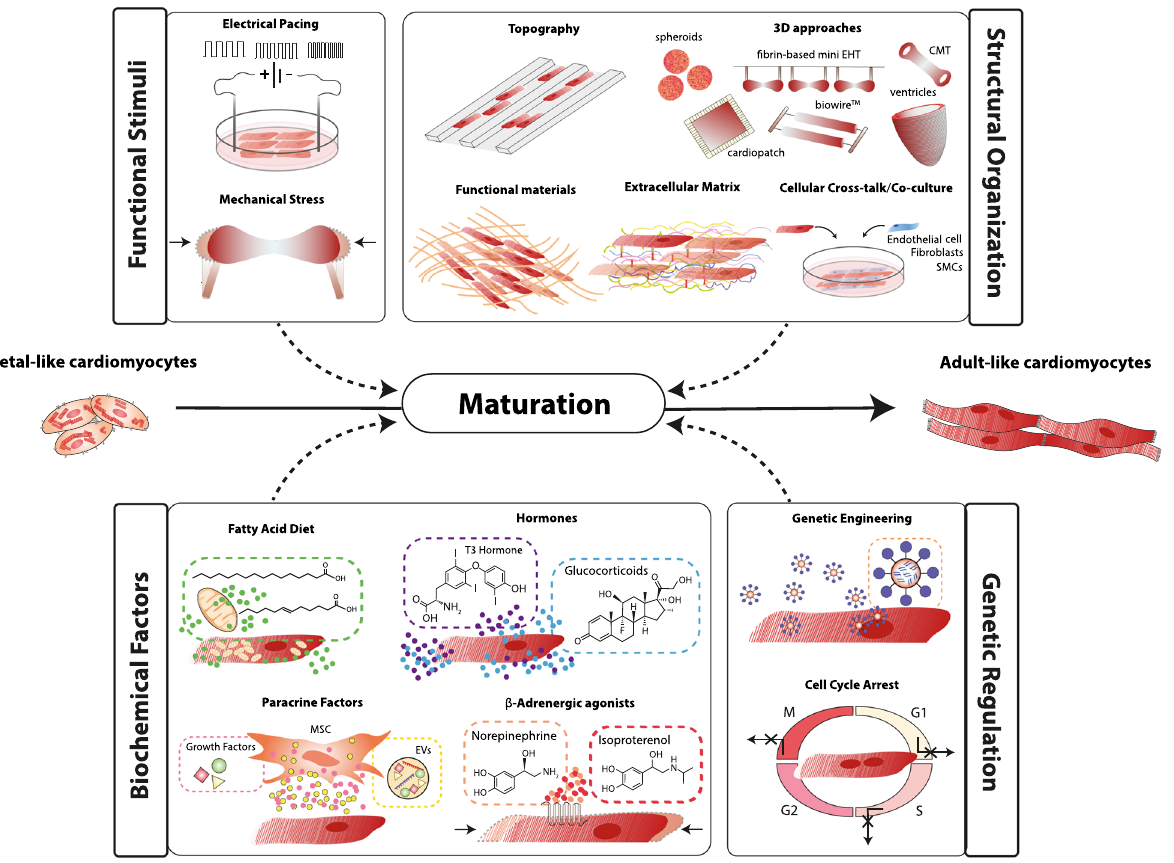
Fig. 2 Bioengineering strategies to improve the maturation of cardiomyocytes derived from human pluripotent stem cells (hPSC-CMs). hPSC-CMs can develop adult-like features with training based on functional stimuli, cues to guide their structural organization, relevant biochemical factors, and by manipulating the genetic program. CMT cardiac microtissue, EHT engineered heart tissue, EV extracellular vesicle, MSC mesenchymal stem cell, SMC smooth muscle cell, T3